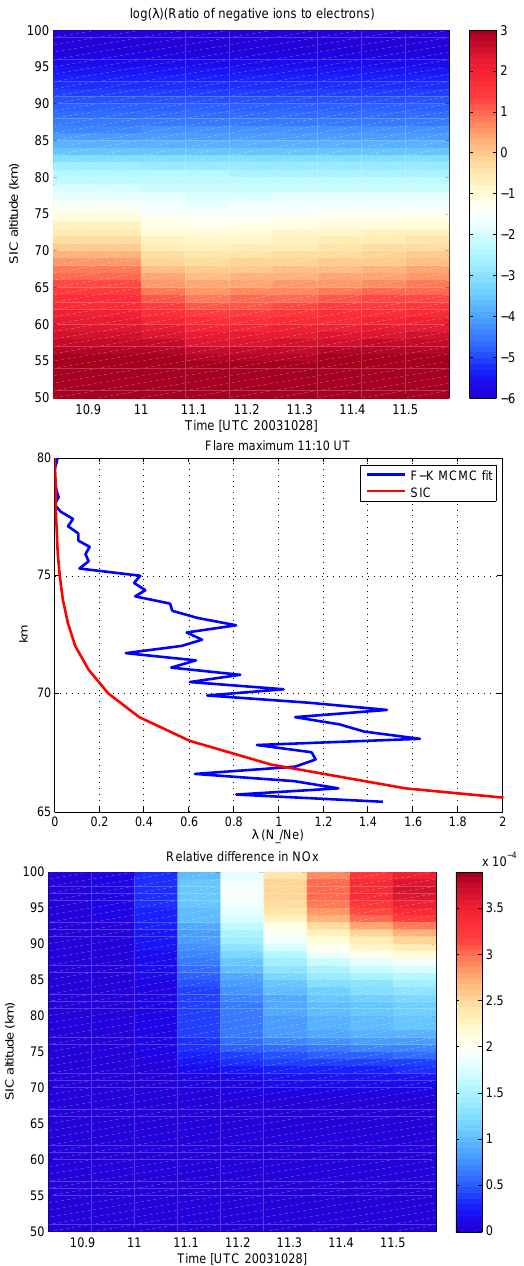
Fig. 6. Upper panel: SIC modelled ratio λ of negative ion to elec- tron density for the 28 October 2003 flare event. Runs start with 100 times the background run NO concentration at 08:00. Mid- dle plot: SIC modelled and F-K MCMC fitted λ for the 28 Octo- ber 2003 flare maximum (11:10UT). Lower panel: Relative NO x (N+NO+NO 2 ) enhancement due to the flare (event run vs control run for 100x background [NO] at 08:00UT). Modelled enhance- ments of less than a few per cent are insignificant, so there is clearly no significant change here.